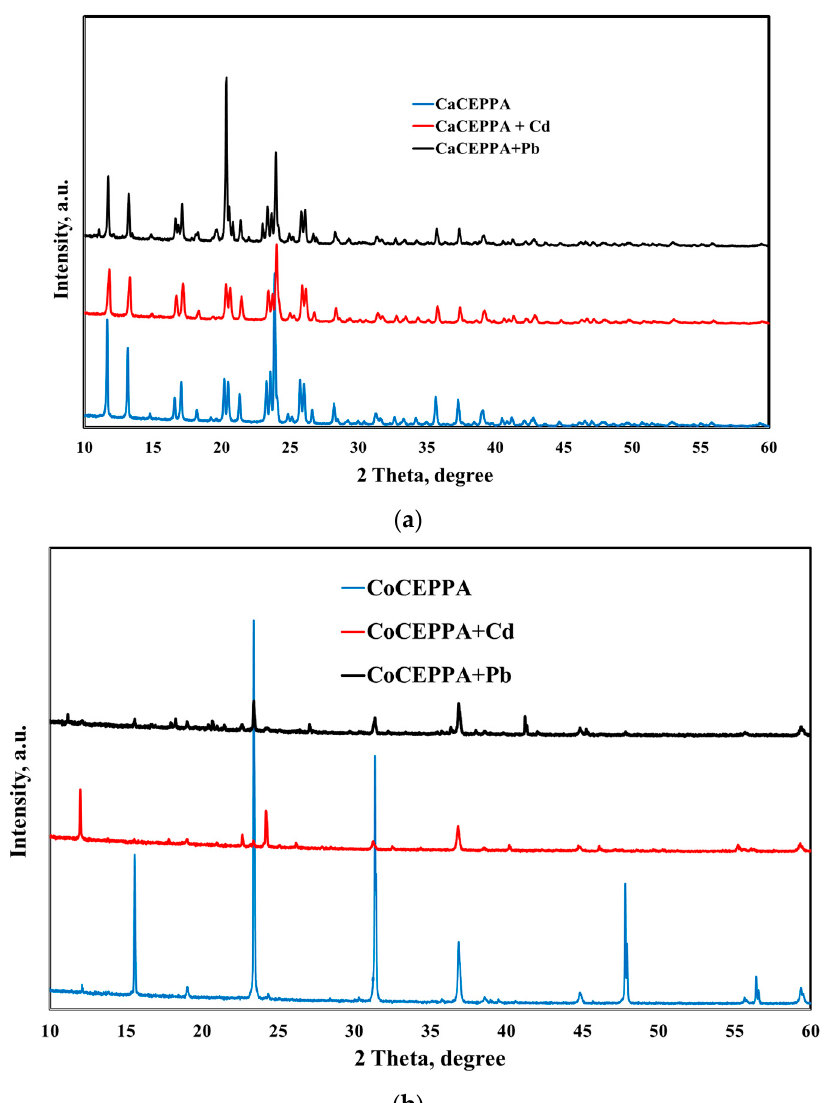
Figure 2. XRD patterns for ( a ) CaCEPPA; ( b ) CoCEPPA before and after adsorption of Cd 2+ and Pb 2+. Judging from the PXRD spectra of both adsorbent materials, the crystallinity is highly affected after the adsorbance of metal ions on the studied materials, in concordance with IR spectra of adsorbents before and after metal ions adsorption. The XRD analysis identified the formation of CdCO 3 or Cd 3 (PO 4 ) 2 , especially in the case of CoCEPPA adsorbent materials (Figure 2b), with two more peaks appearing at 22.67 ◦ and 24.19 ◦ . For CaCEPPA, these peaks are covered by the peaks specific to the based materials [45]. In the case of lead adsorption, it is also highlighted that some complexes are formed at the adsorbent surface due to the appearance of new peaks at 2 θ = 11.1 ◦ and 16.6 ◦ [46] in the XRD spectrum of both studied materials. To gain a deeper understanding of the mechanism of adsorption, in addition to the isothermal and kinetic studies, FTIR spectra of Pb(II)-impregnated and Cd(II)-impregnated CoCEPPA and CaCEPPA were recorded and compared to that of pristine CoCEPPA and CaCEPPA (Figure 3a,b). The results indicate that chemisorption may be the main adsorption mechanism, with the carboxylic oxygen in both CoCEPPA and CaCEPPA potentially coordinating with the Pb 2+ and Cd 2+